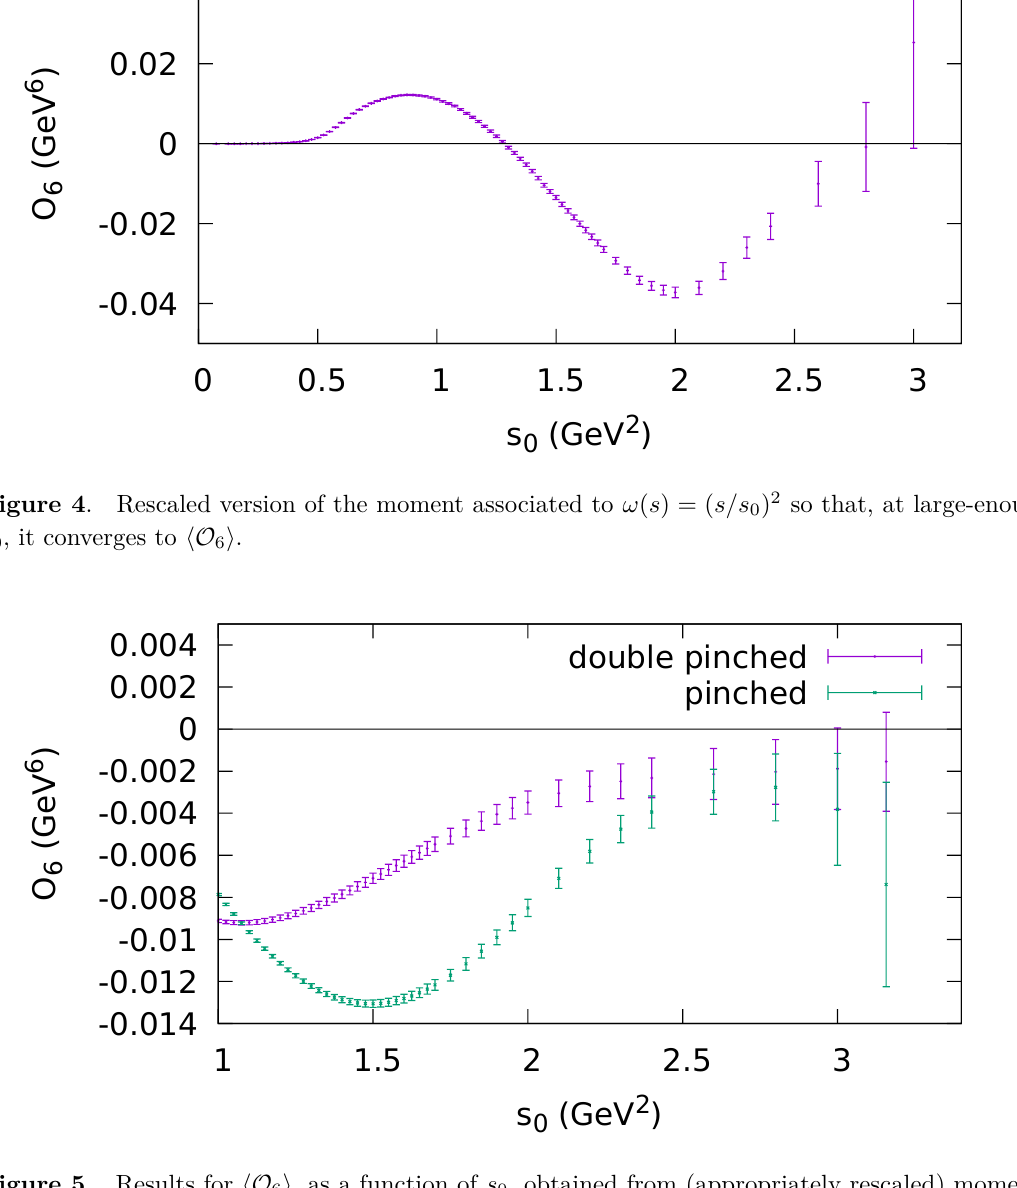
Figure 5 . Results for hO 6 i , as a function of s 0 , obtained from (appropriately rescaled) moments with pinched